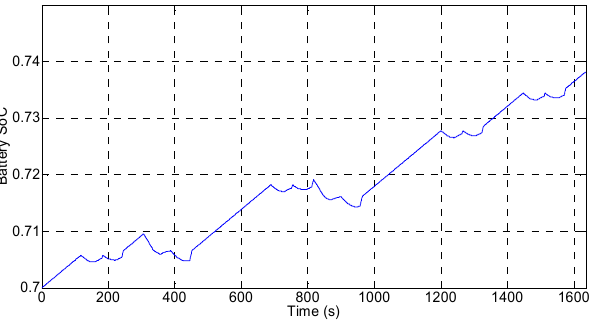
Figure 16. SoC of the lithium battery under intermittent work.